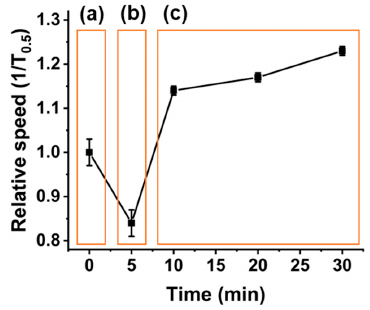
Figure 3. Measuring the change in the DNAzyme functionalised nanocarrier velocity versus different incubation times with Ca 2+ ions; ( a ), blank DNAzyme complex on the bead, ( b ) cleavage of the DNAzyme from dsDNA to ssDNA, and ( c ) DNAzyme rearranging. Samples were run in triplicate.